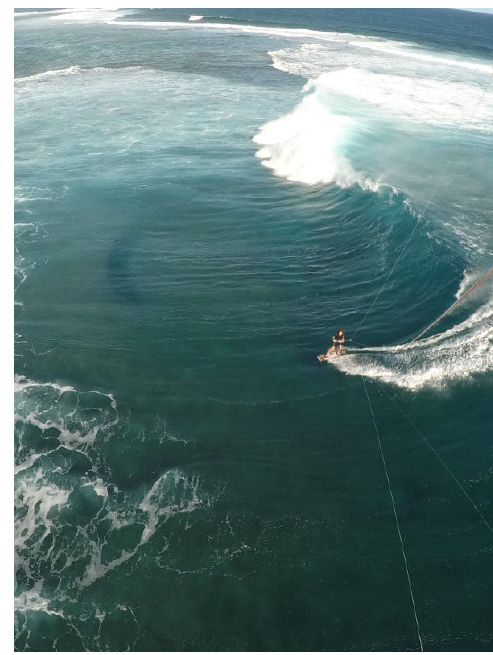
Figure 1. Citizen kite collecting underwater and aerial pictures while surfing above coral reefs (Mauritius)